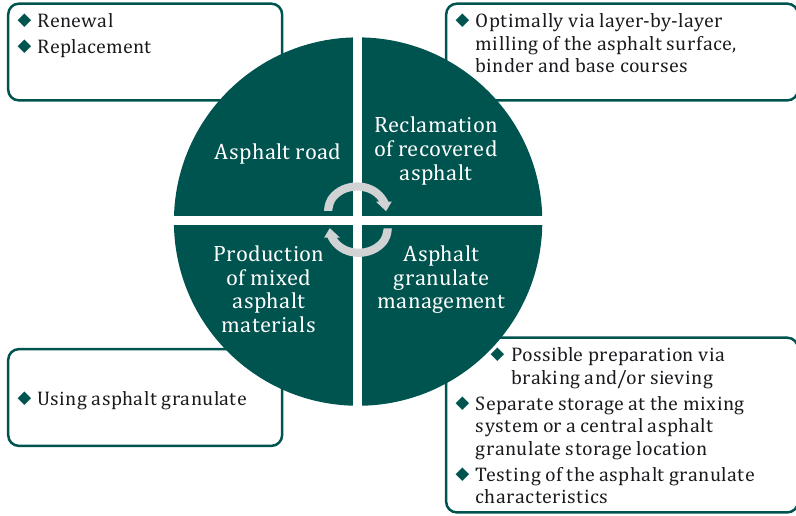
◆ Optimally via layer-by-layer milling of the asphalt